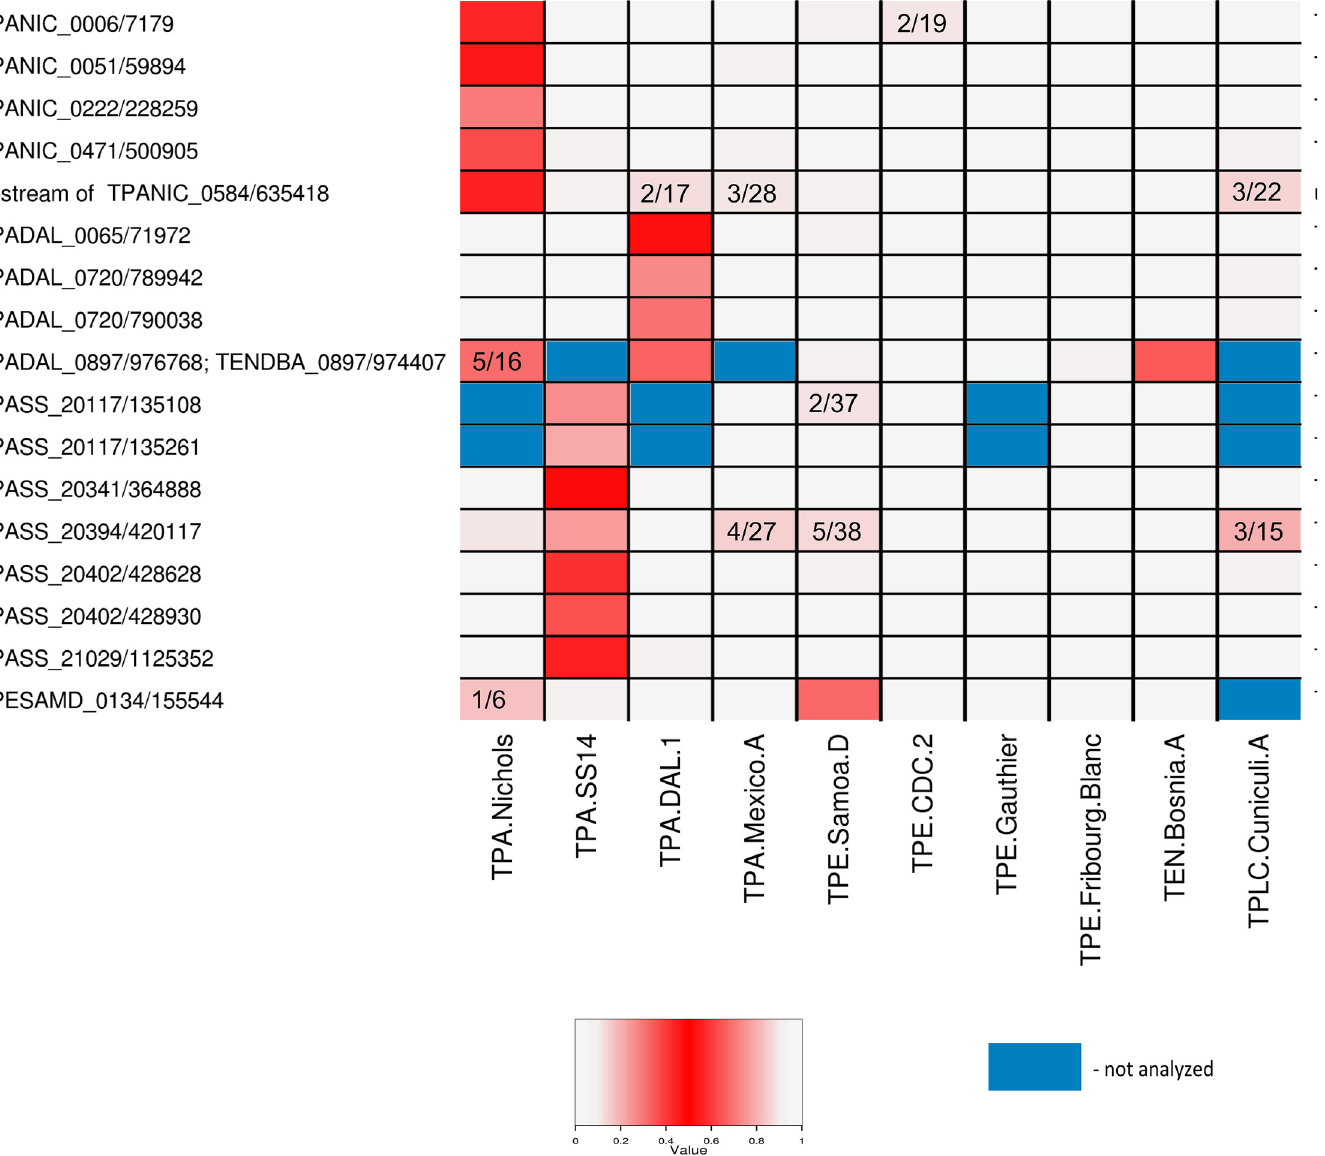
Fig 2. A schematic representation of the identified heterogeneous positions in all investigated genomes. The proportion of alternative alleles is based on nucleotide frequency within individual Illumina reads. While red cells represent identified sites of intrastrain heterogeneity, grey cells represent sites of intrastrain homogeneity. The numbers within cells indicate the number of alternative/standard reads in the sites where the number of alternative reads exceeded 10% but were lower than 20% and therefore remained below the threshold used in this study. Blue cells show nucleotide positions omitted from analysis due to excluded paralogous sequences (S2 Table). For the Bosnia A strain, the intrastrain heterogeneous sites TENDBA_0314/331578, TENDBA_0314/331618, TENDBA_0317/333355 and TENDBA_0621/672156 are not shown because in all other genomes these positions were excluded from analysis due to paralogous sequences. Note that the TPADAL_0897/976678 and TENDBA_0897/974407 positions are the same.